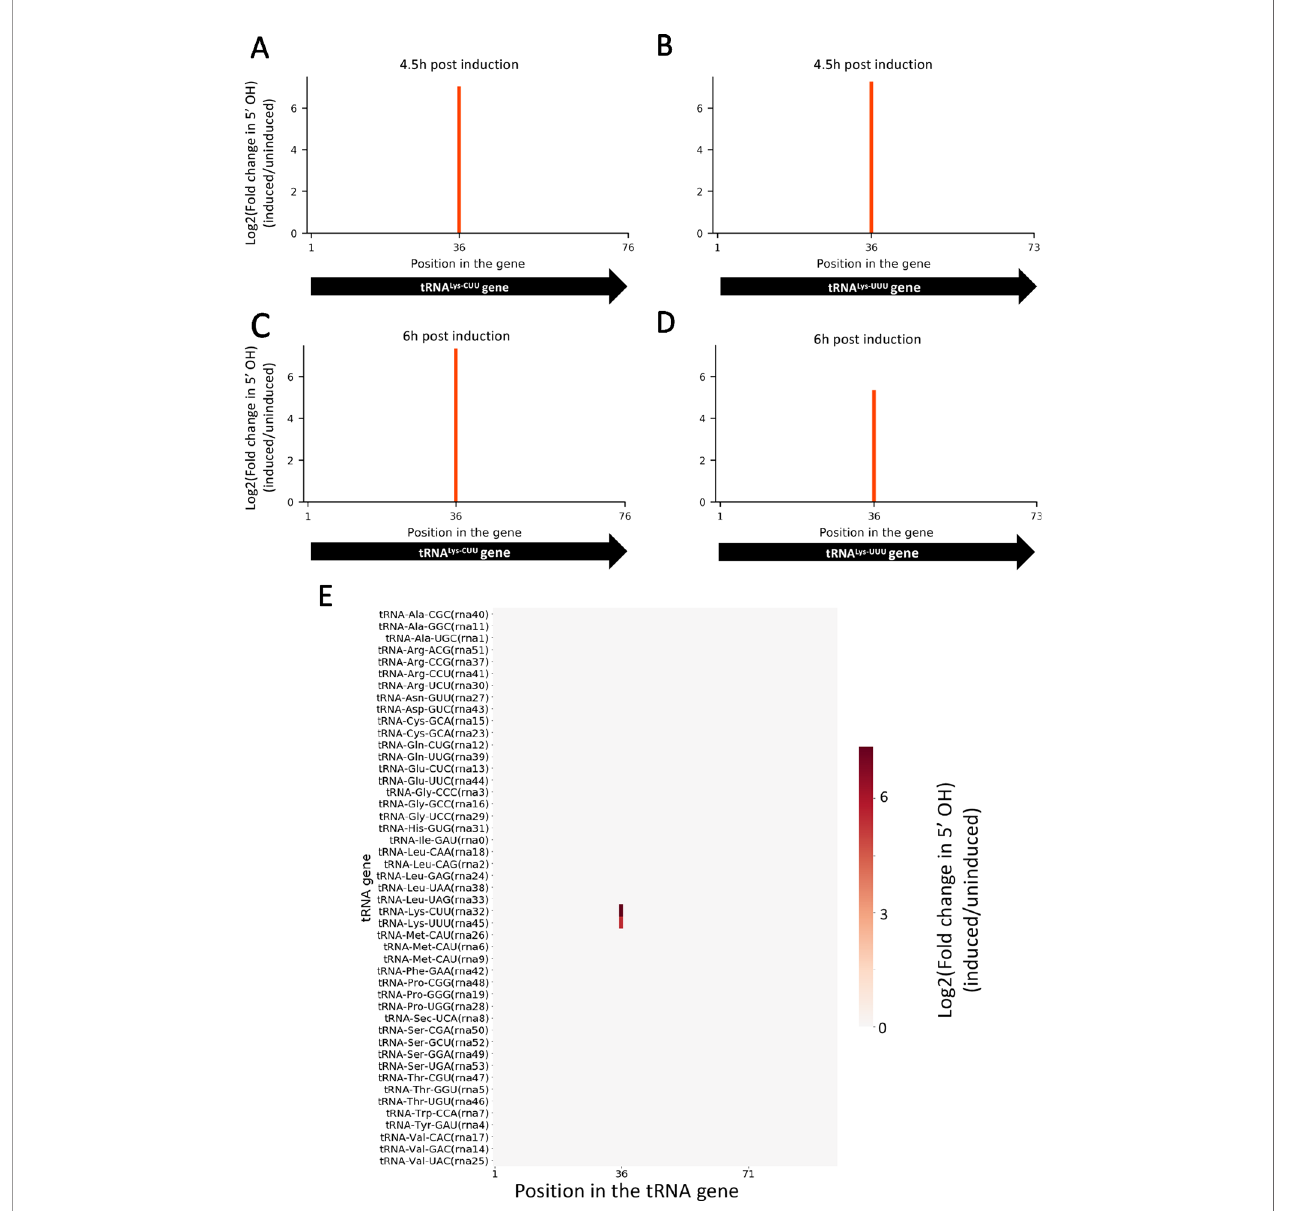
FIGURE 2 | MazF-ms selectively targets both tRNA Lys isoacceptors. (A – D) Fold changes of 5 ’ OH (indicating endonucleolytic cleavage) within both tRNA Lys-CUU and tRNA Lys-UUU genes detected by 5 ’ RNA-seq. M. smegmatis cells expressing MazF-ms for 4.5 (A, B) or 6 h (C, D) were compared to uninduced controls. (E) Heatmap showing the fold change in 5 ’ OH levels in each position of all 47 M. smegmatis tRNA genes after 6 h of MazF-ms induction. The annotated tRNA gene ID (from genome CP000480.1) is shown in